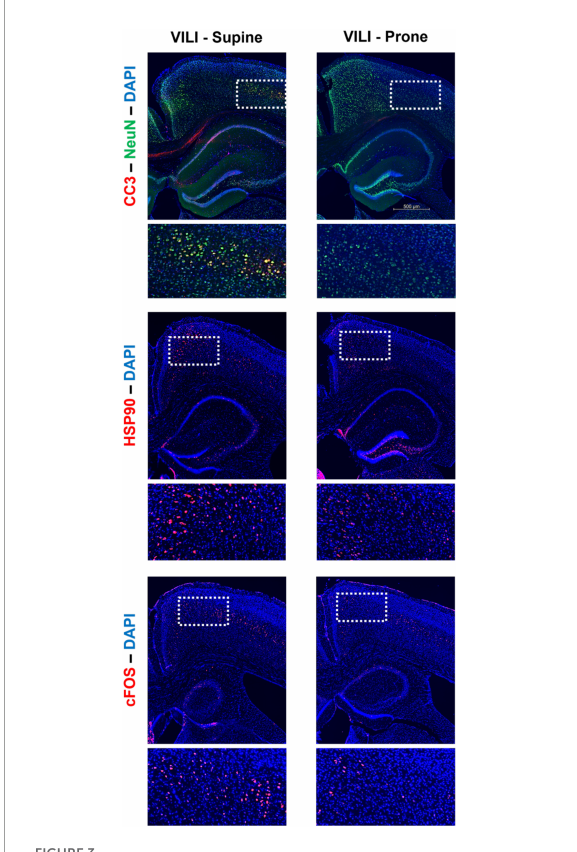
FIGURE3 Characteristic staining of cortical cleaved caspase-3 (CC3), heat shock protein 90 (Hsp90), c-Fos , and neuronal nuclear protein (NeuN) in both supine and prone positioned